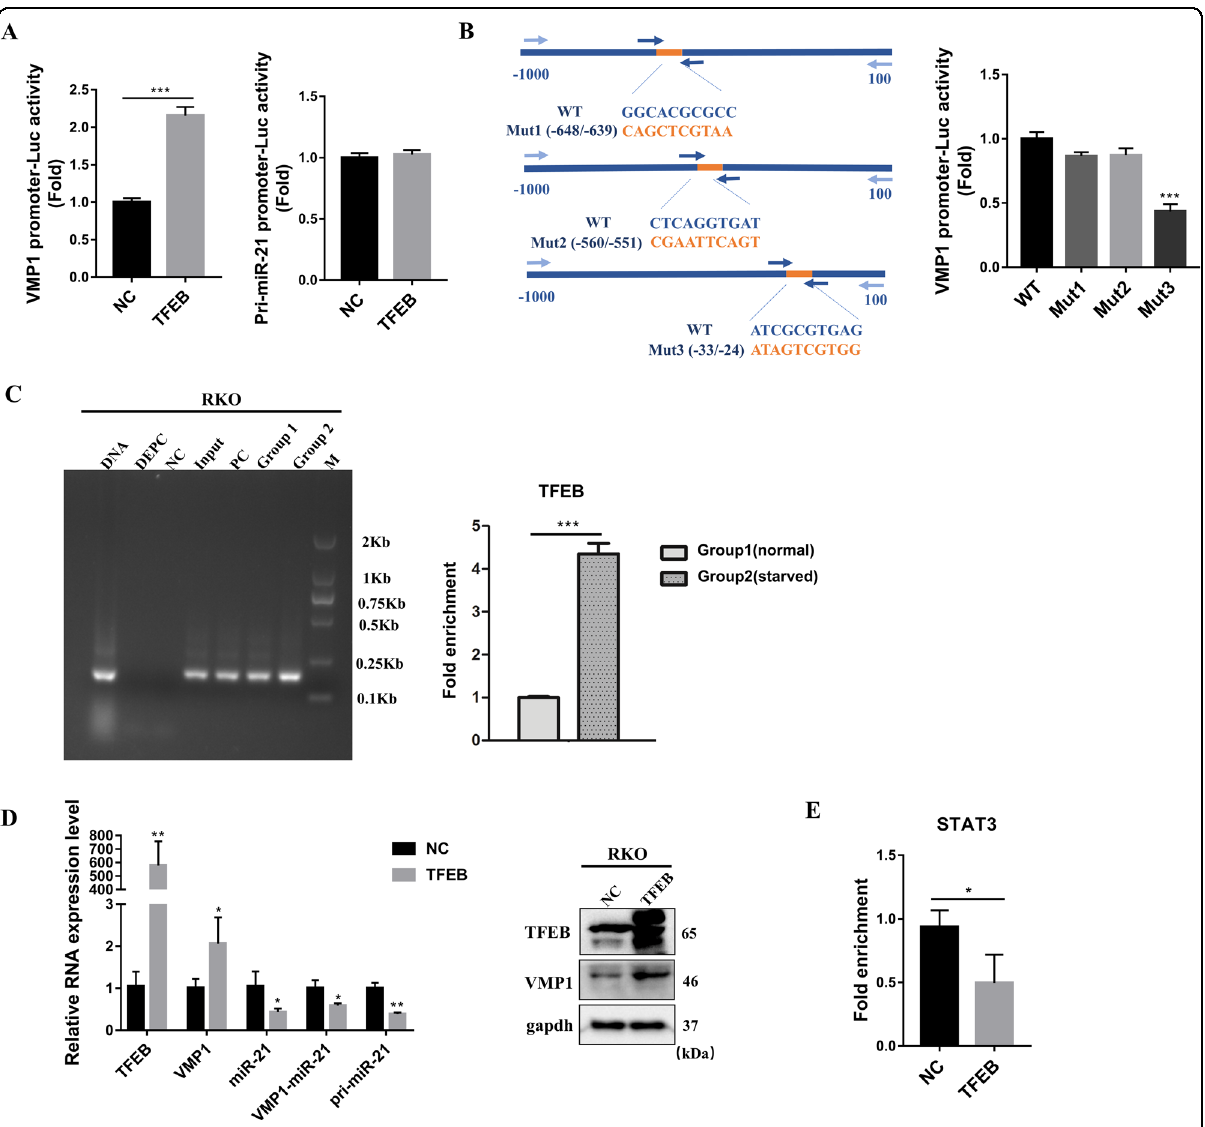
Fig. 4 TFEB regulates VMP1 transcription by directly binding to the promoter region of VMP1. a RKO was transfected with pCIP-caTfeb vector and the construct dual-luciferase vectors, pmiRGLO-VMP1 promoter ( − 1000/ + 100) or pmiRGLO-pri-miR-21 promoter ( − 1000/ + 100), the luciferase activity was measured. b Luciferase report assay using the construct vector carrying the VMP1 promoter region, in which the predicted most likely three binding site ( − 648/ − 639, − 560/ − 551, − 33/ − 24, the upstream of the transcription start site of VMP1) with TFEB was mutant. c DNA Agar-gel electrophoresis from CHIP-qPCR assay, the amount of immunoprecipitated DNA isolated from TFEB special antibody/protein G magnetic beads was measured by qPCR. Primer speci fi c for VMP1 promoter region ( − 116/ + 27). NC: negative control, PC: positive control, Group1: cells with no treat, Group2: cells with glucose starvation. d The mRNA expression level of TFEB, VMP1, miR-21 and the number of pri-miR-21 and VMP1-miR-21 transcripts were measured by qPCR, the protein expression level of TFEB and VMP1 were measured by Western blot after overexpression of the constitutively active TFEB by pCIP-caTfeb vector in RKO cells. e RKO was transfected with pCIP-caTfeb vector, then CHIP-qPCR analyses using phospho-STAT3 (Tyr705) special antibody were performed. Data are presented as mean ± SD. *** P < 0.001, ** P < 0.01, * P <